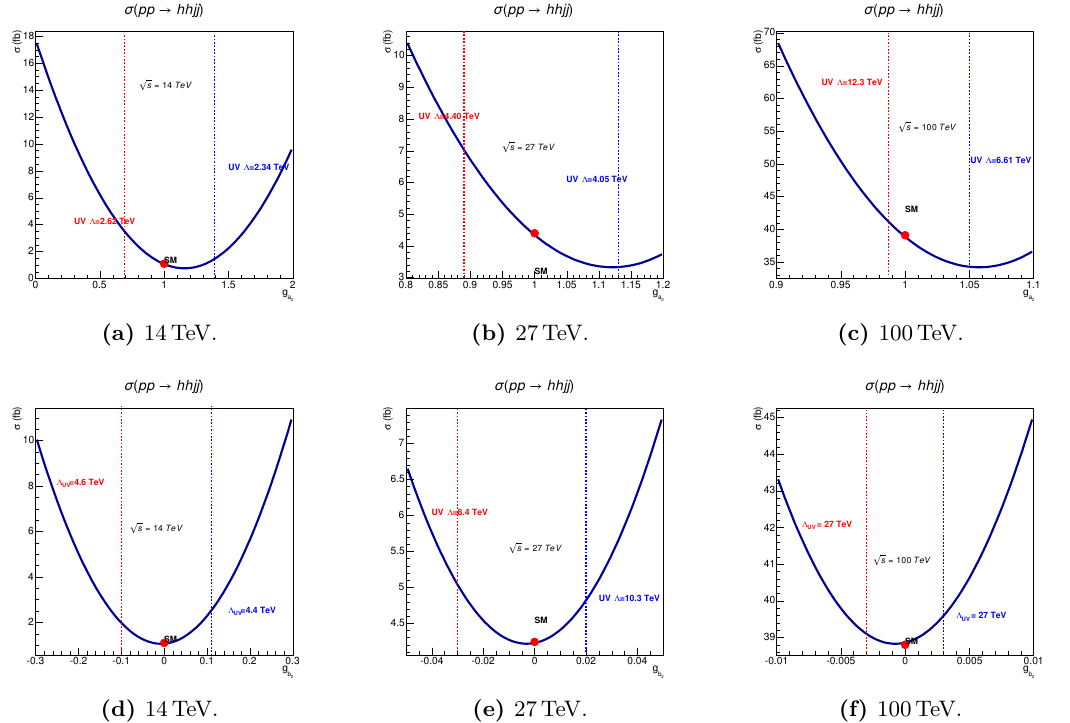
Figure 8 . Total cross section after VBF cuts for the process pp → hhjj as a function of the WWhh couplings g (upper row) and g (lower row), for three different collider energies. The vertical V,a 2 V,b 2 lines are unitarity bounds, which are derived from eq. (4.3) and eq.